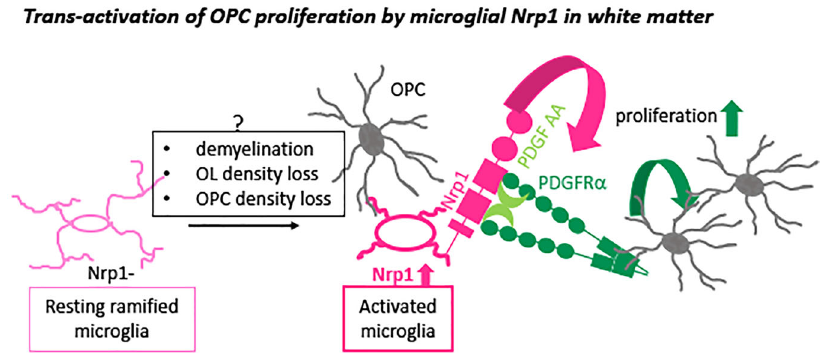
Fig. 8 Proposed mechanism of action of microglial Nrp1 on OPC proliferation. Resting rami fi ed microglia (homeostatic microglia) that do not express Nrp1 (left, light pink) become activated and upregulate Nrp1. Nrp1 on activated microglia stimulates phosphorylation of PDGFR α on adjacent OPCs (gray) and promotes PDGF AA-dependent OPC proliferation. Question mark above the gray box indicates that the mechanism that causes Nrp1 upregulation on activated microglia is